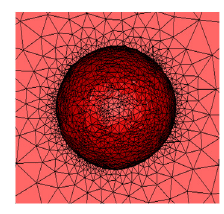
Figure 3. Meshing of the porosity.